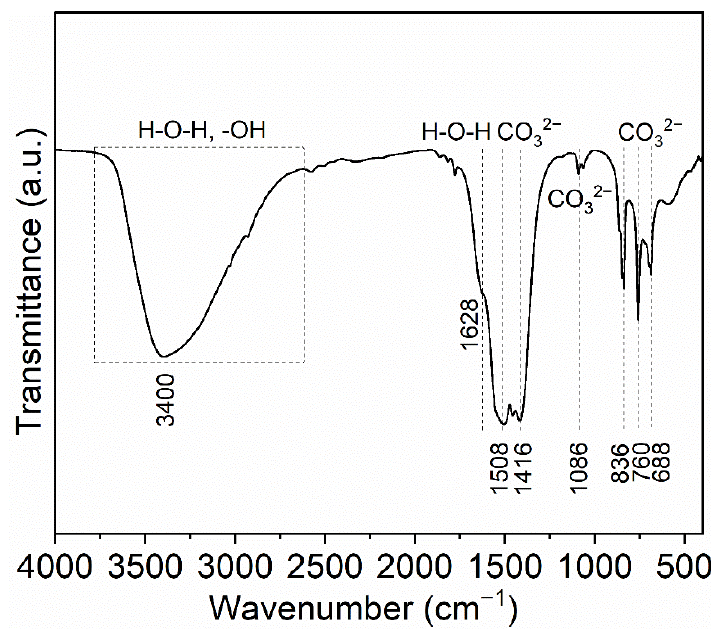
Figure 2. FTIR spectrum of the synthesized precursor.